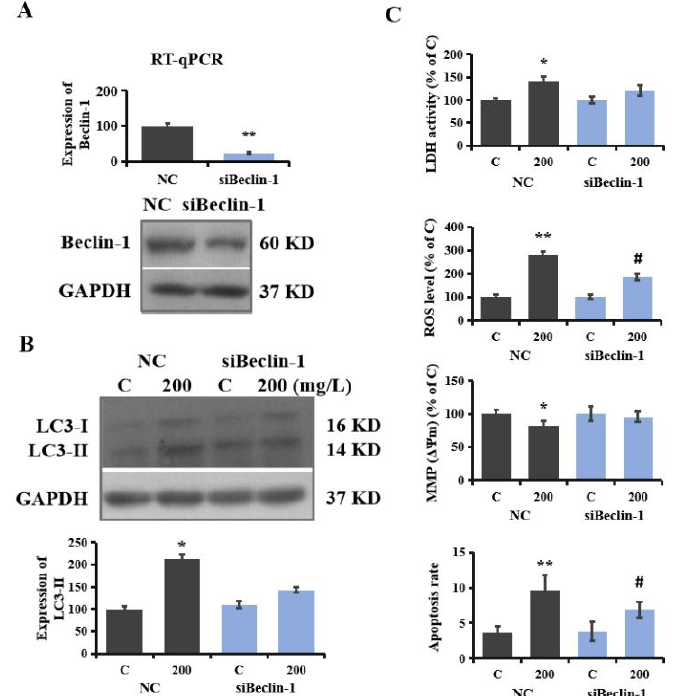
Figure 4. Autophagy-regulated neurotoxicity induced by PS-NPs. ( A ): SHSY-5Y cells were transfected with sh-pBeclin-1 and sh-pGIPZ plasmids to construct Beclin-1 RNAi cells (siBeclin-1) and negative cells (NC). The expression of Beclin-1 was analyzed with RT-qPCR and Western blotting. NC and siBeclin-1 cells were treated with 200 mg/L of PS-NPs, and then the expressions of LC3-II were measured with Western blotting, and the expressions of proteins were quantified ( B ). The LDH activity, ROS level, MMP, and apoptosis rate were measured ( C ). In the C (control) group, SHSY-5Y cells were only treated with medium. * p < 0.05 and ** p < 0.01, compared to the control. # p < 0.05, siBeclin-1 group compared to the NC group.